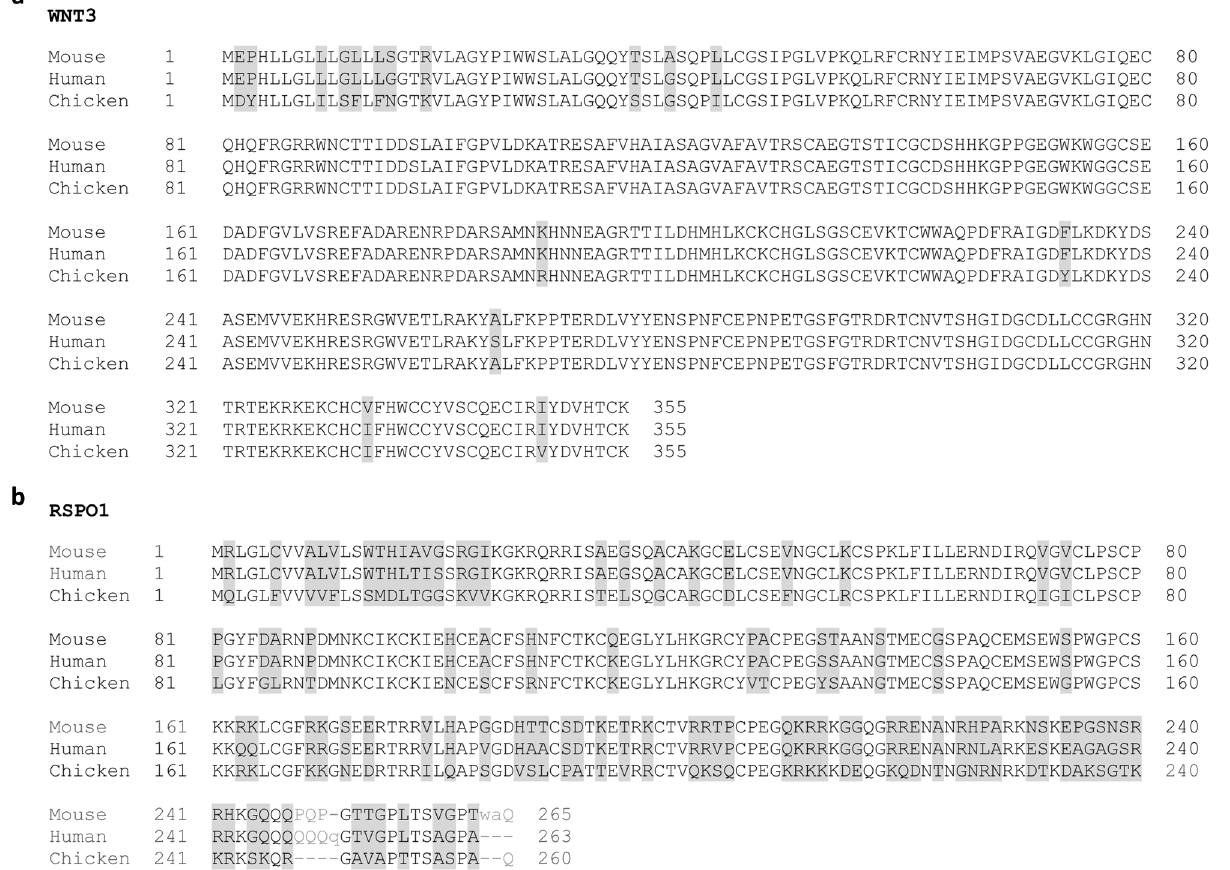
Figure 2. Sequence alignments of ( a ) WNT3 protein for mouse, human and chickens. Chicken vs mouse and chicken vs human are 96% identical (human vs mouse: 98%). ( b) Alignment of RSPO1 for mouse, human and chicken. Chicken and mouse is 65% identical and chicken and human is 68% (human and mouse: 89%). Non- consensus amino acids